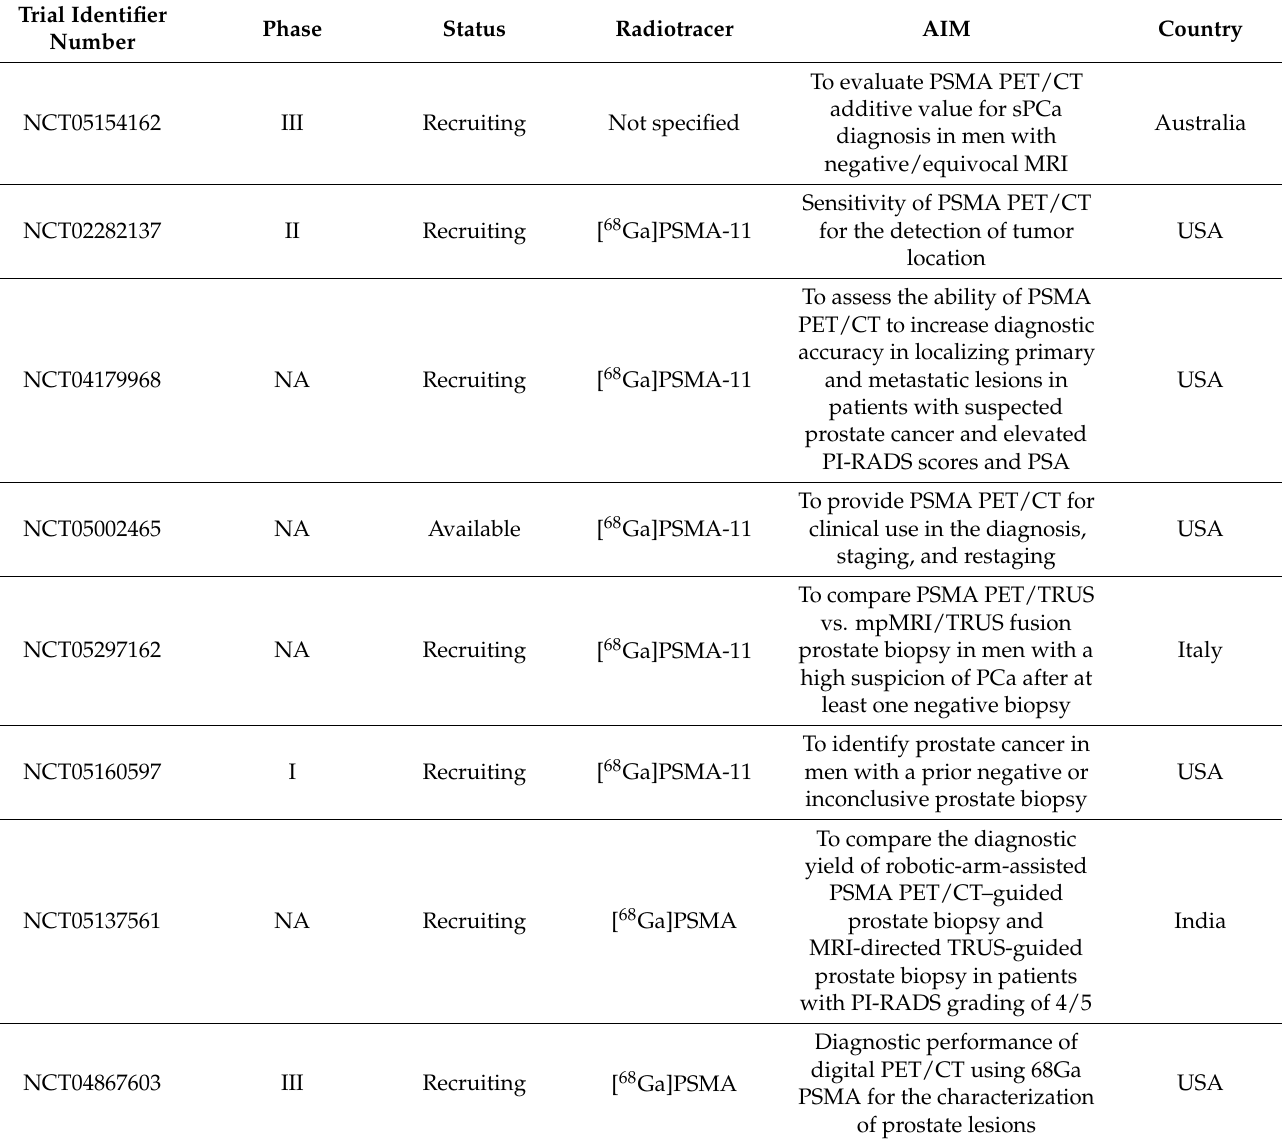
Table 3. Summary of the ongoing clinical trials with PSMA PET/CT for the initial detection of PCa (source: https://clinicaltrials.gov/), accessed up to 28 February